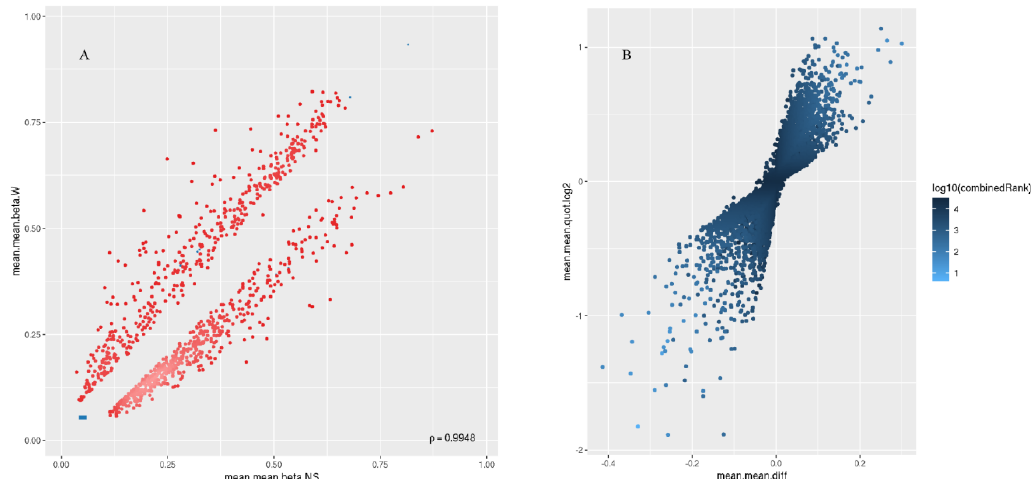
Figure 3. Comparing the density distributions of methylation levels (β) in ( A ) W and NS and in ( B ) the CpG content. In ( B ), it can be seen that the island relation has more β value density than other CpG content.